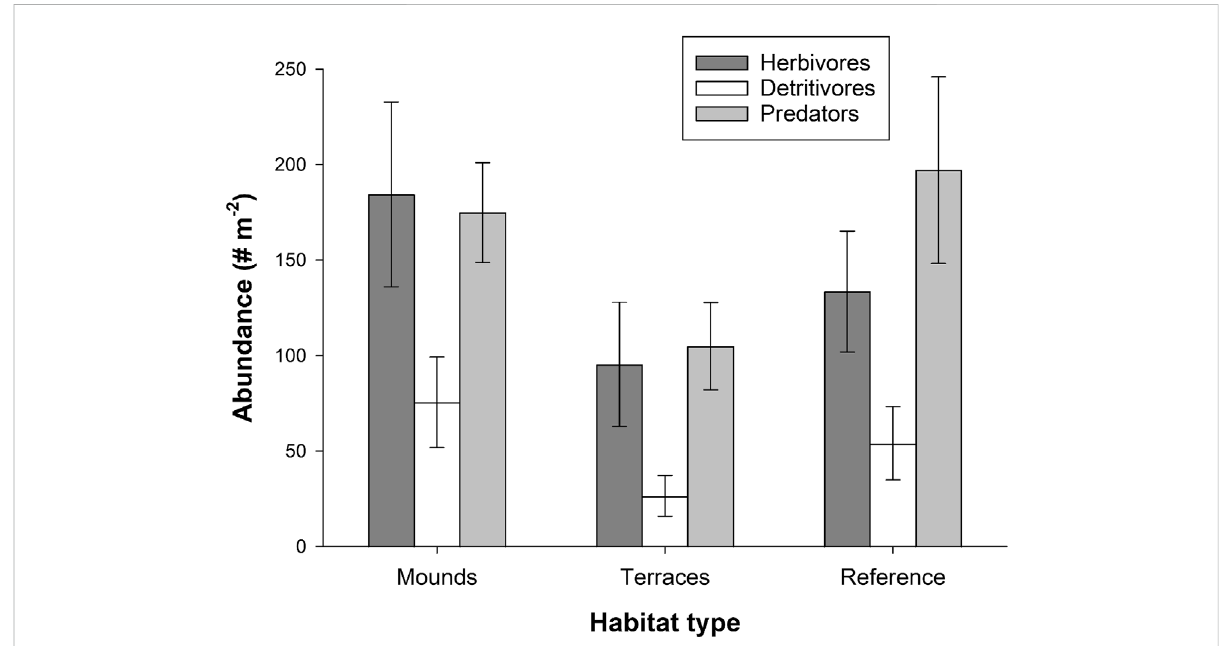
FIGURE 3 Abundance of terrestrial arthropod functional groups at two restored habitat types (mounds and terraces) and in reference areas. Error bars depict standard